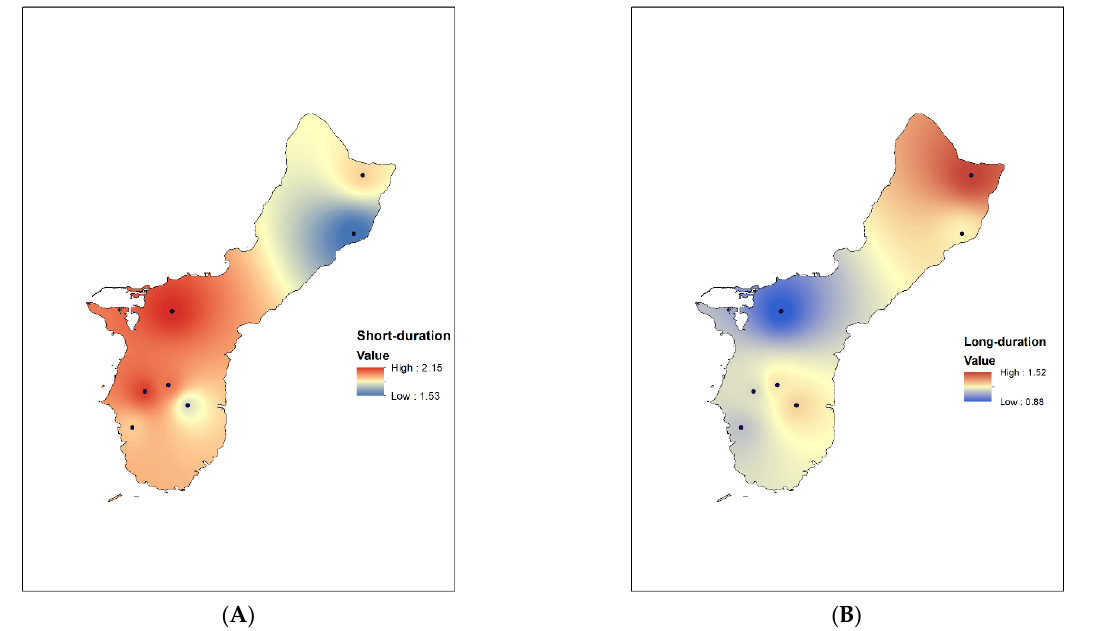
Figure 7. Interpolated scaling exponents for both short duration ( A ) and long duration ( B ).